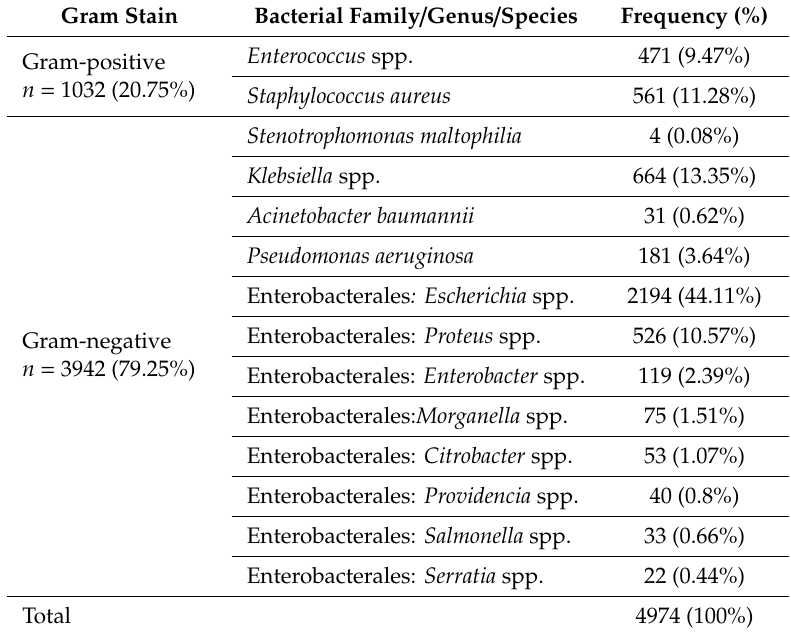
Table 1. Epidemiology and distribution of ESKAPE pathogens during the study